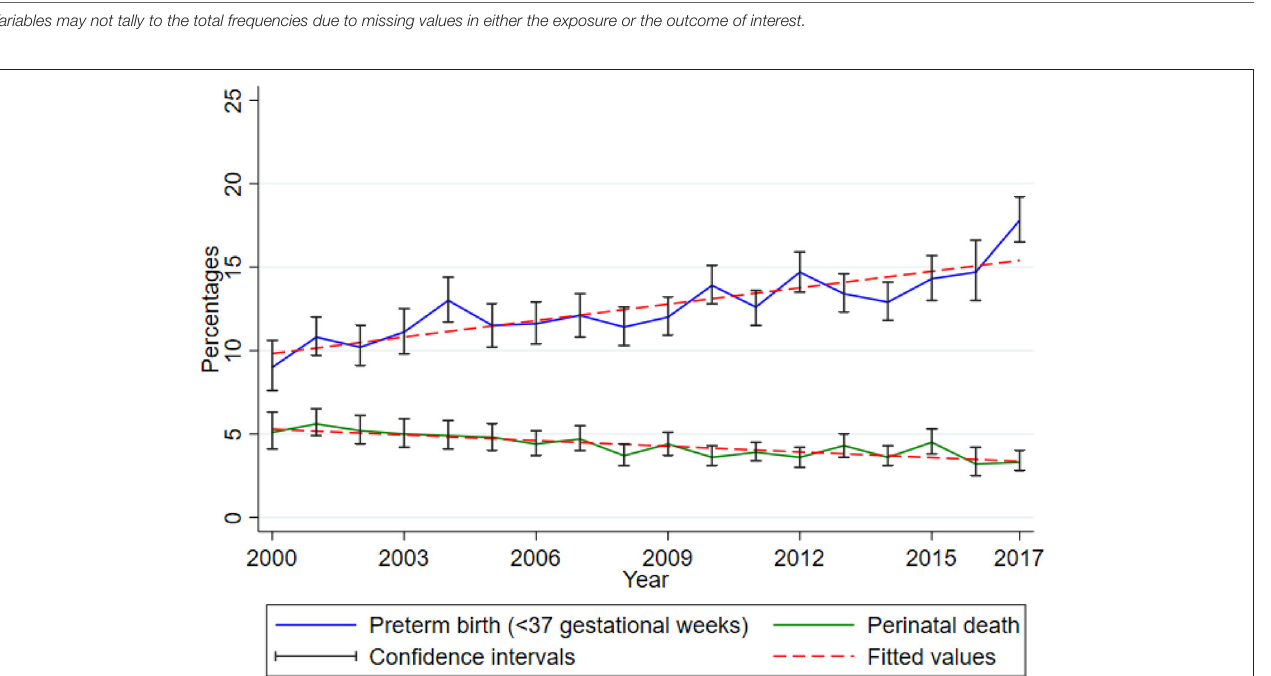
increased the odds of perinatal death (OR = 1.43, 95% CI 1.18,